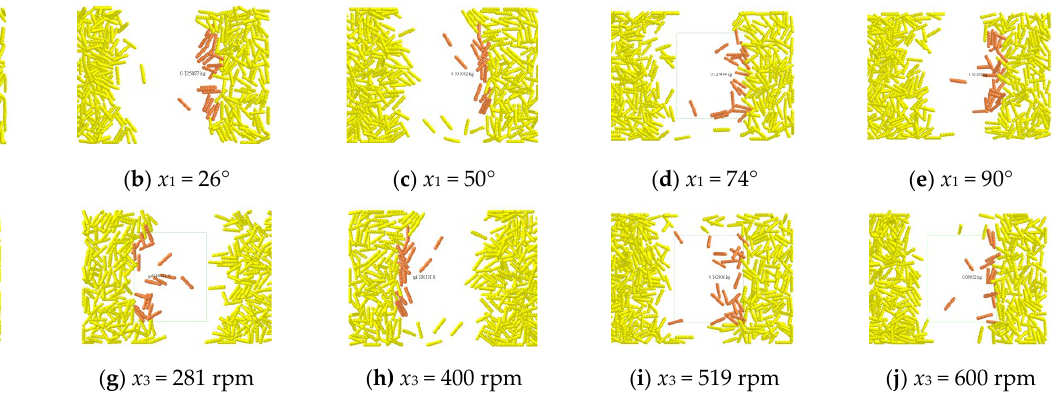
Figure 8. Straw-clearing effect graph of discrete element simulation test. ( a – e ) Straw-clearing effect graph of different values of the edge angle of cutting conditions when the rotation radius of the knife and the rotation speed of the knife roller were located at the design center point. ( f – j ) Straw-clearing effect graph of different values of the rotation speed of the knife roller conditions when the edge angle of cutting and the rotation radius of the knife were located at the design center point.